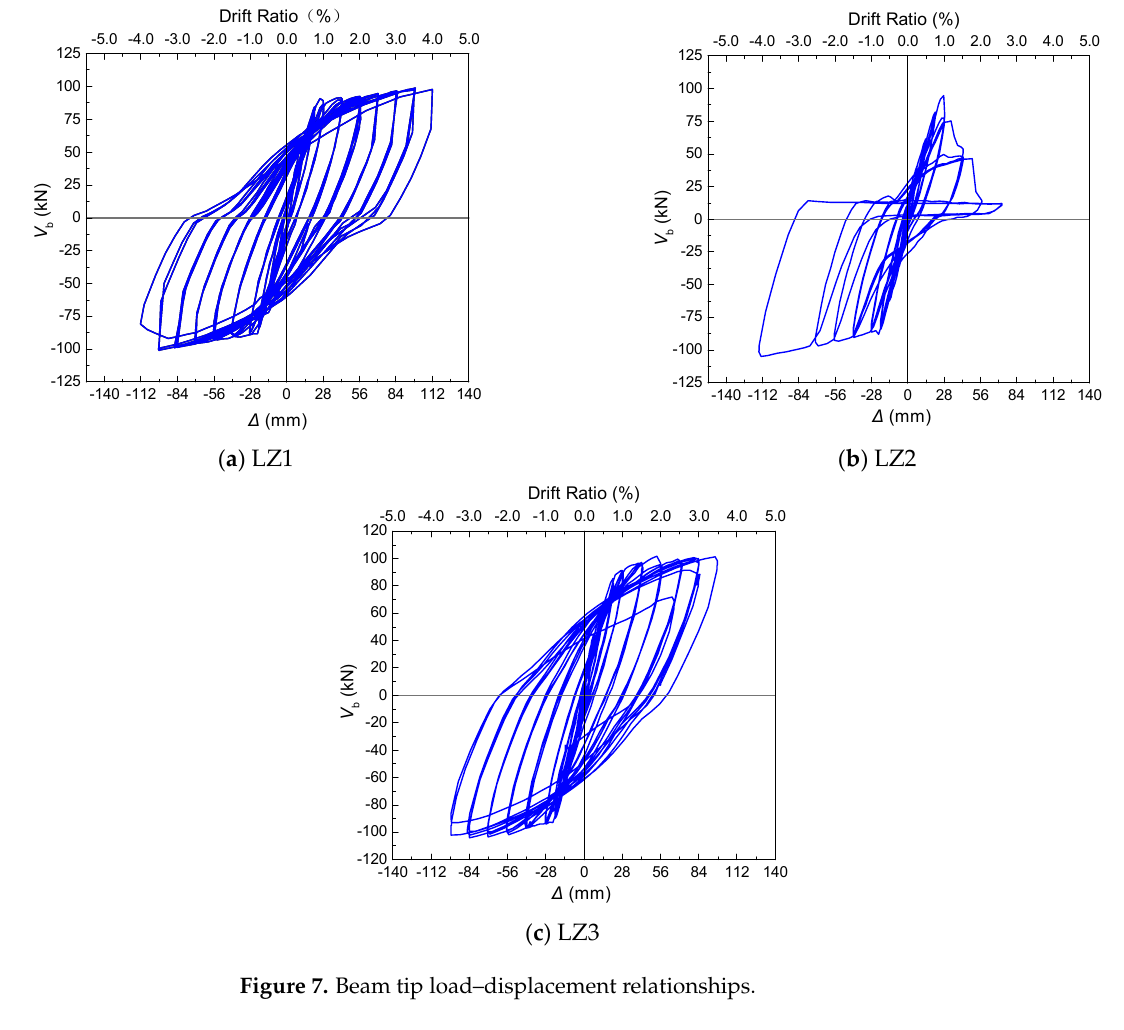
Figure 7. Beam tip load–displacement relationships.